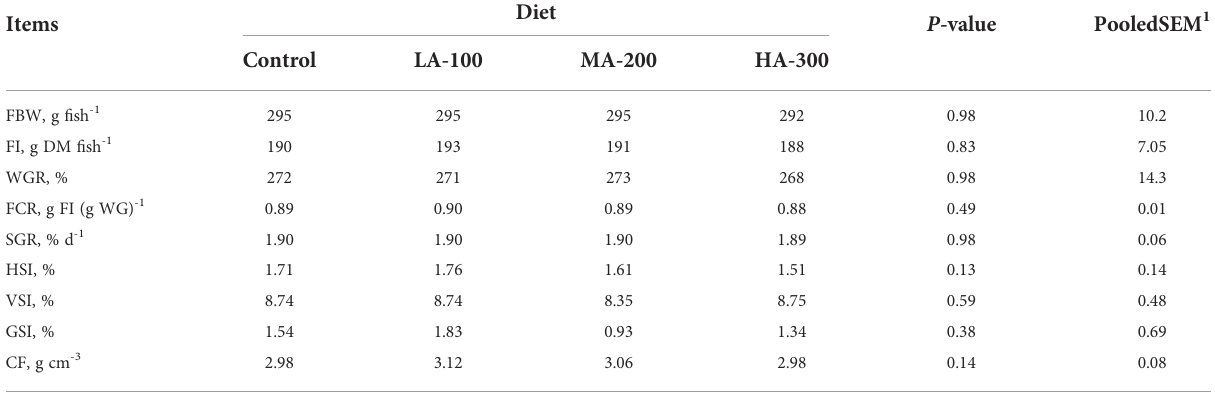
TABLE 1 Growth performance and morphologic index of largemouth bass fed diets with different levels of b